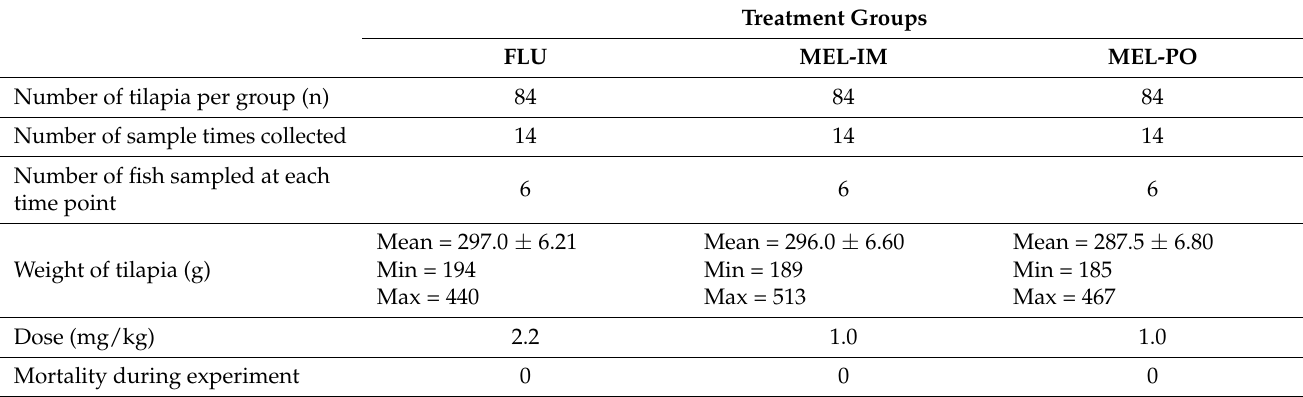
Table 1. Experimental design and mean weights of the FLU, MEL-IM, and MEL-PO groups at the time of drug administration in